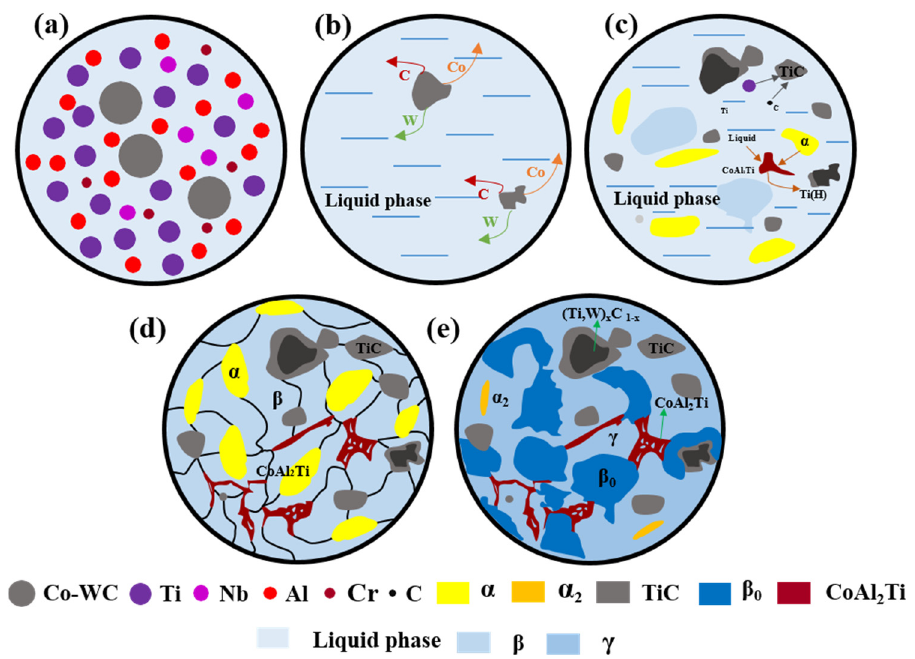
Figure 7. Schematic diagram of the 10 WC and 15 WC composite coatings during the solidification process. ( a ) The condition of powder before laser cladding; ( b ) The condition of molten pool; ( c ) The state in which the phases begin to precipitate during solidification; ( d ) A state in which the liquid phase has all disappeared; ( e ) Final phase distribution at room temperature.